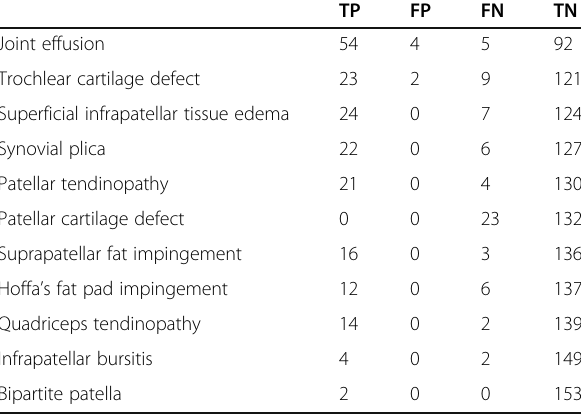
Table 3 Frequency of each finding as detected